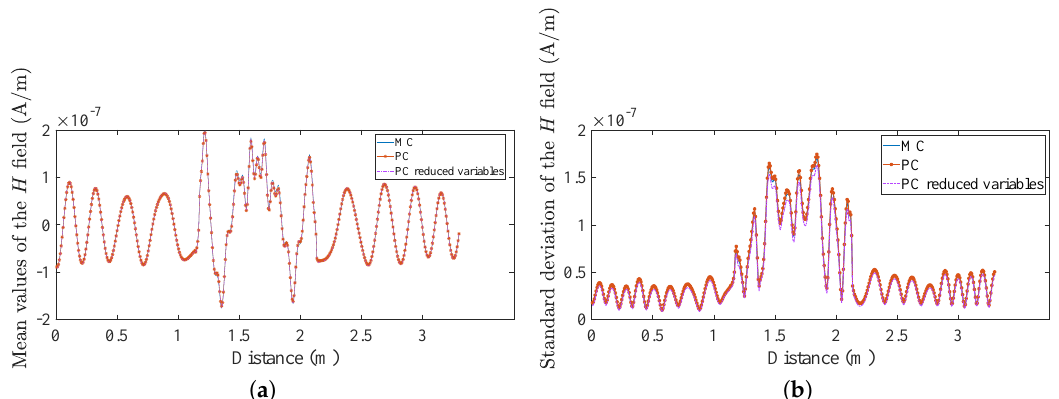
Figure 6. ( a ) Mean value and ( b ) standard deviation of the magnetic field for the first case of the second